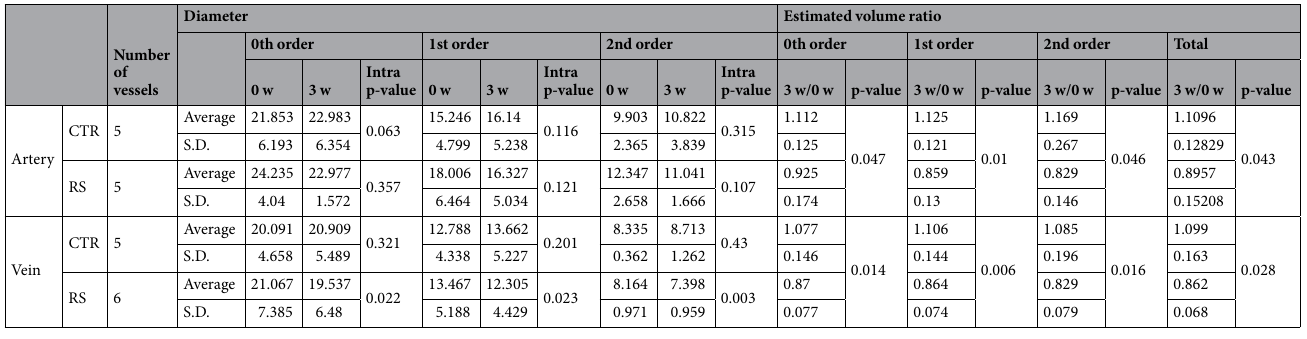
Table 2. Estimated diameter and reconstructed volume of selected blood vessels based on vessel type and branching